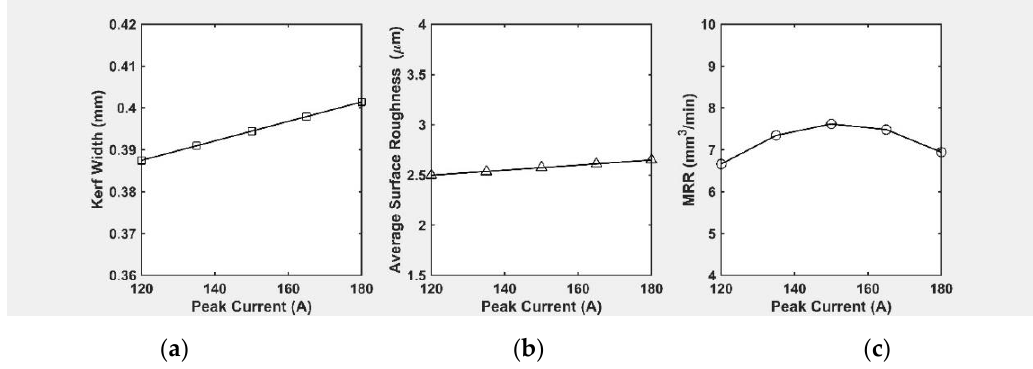
Figure 7. Effects of peak current (I P ) on ( a ) kerf width, ( b ) surface roughness, and ( c ) MRR.